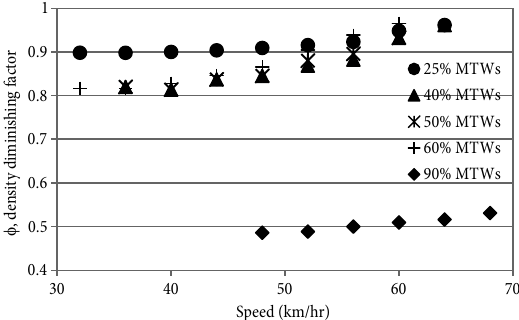
Fig. 8. Variation of threshold speed for lane-sharing with the proportion of